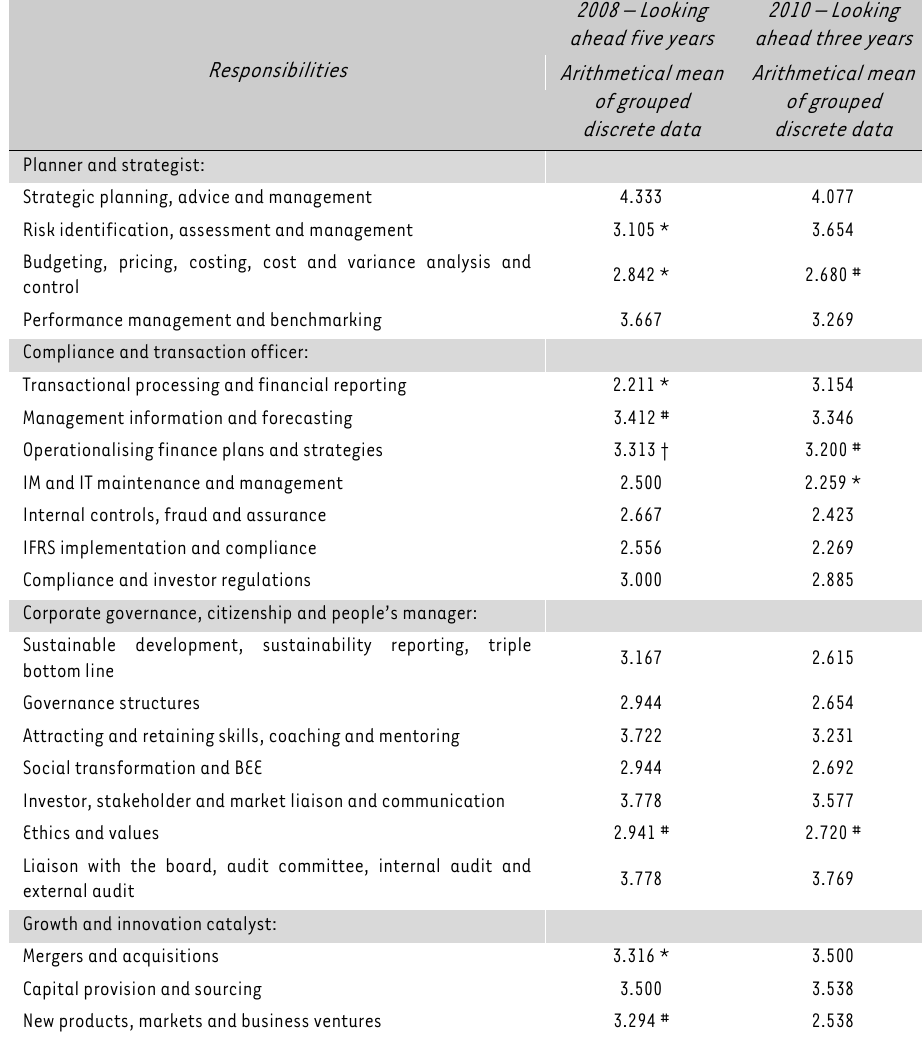
TABLE 14: Comparison of time spent on their responsibilities per role in the future Responsibilities